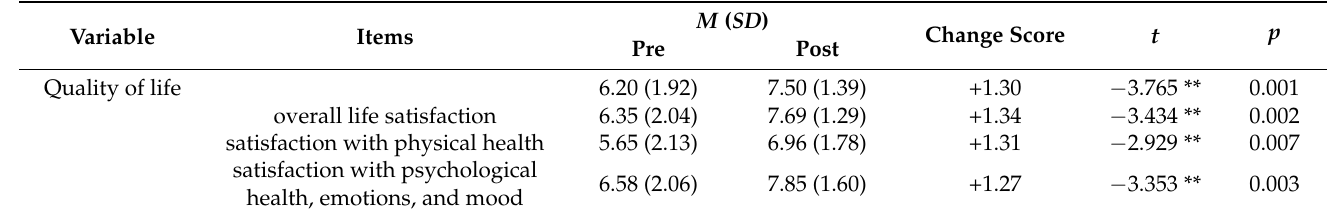
Table 4. Comparison of quality of life between before and after exercise program